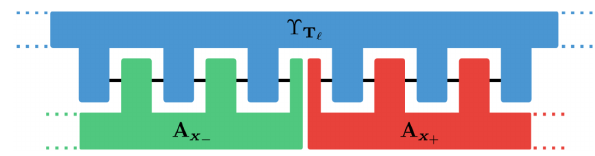
FIG. 27. Determining whether a quantum process is Marko- vian. Generalized testers (multitime instruments) A x are applied to the system during a quantum process, where the subscripts represent the outcomes. The testers are chosen to implement a causal break at a timestep t k , which ensures that the only way the future outcomes depend on the past if the process is non-Markovian. Thus by checking if the future depends on the past for a basis of instruments we can certify the process to be Markovian or